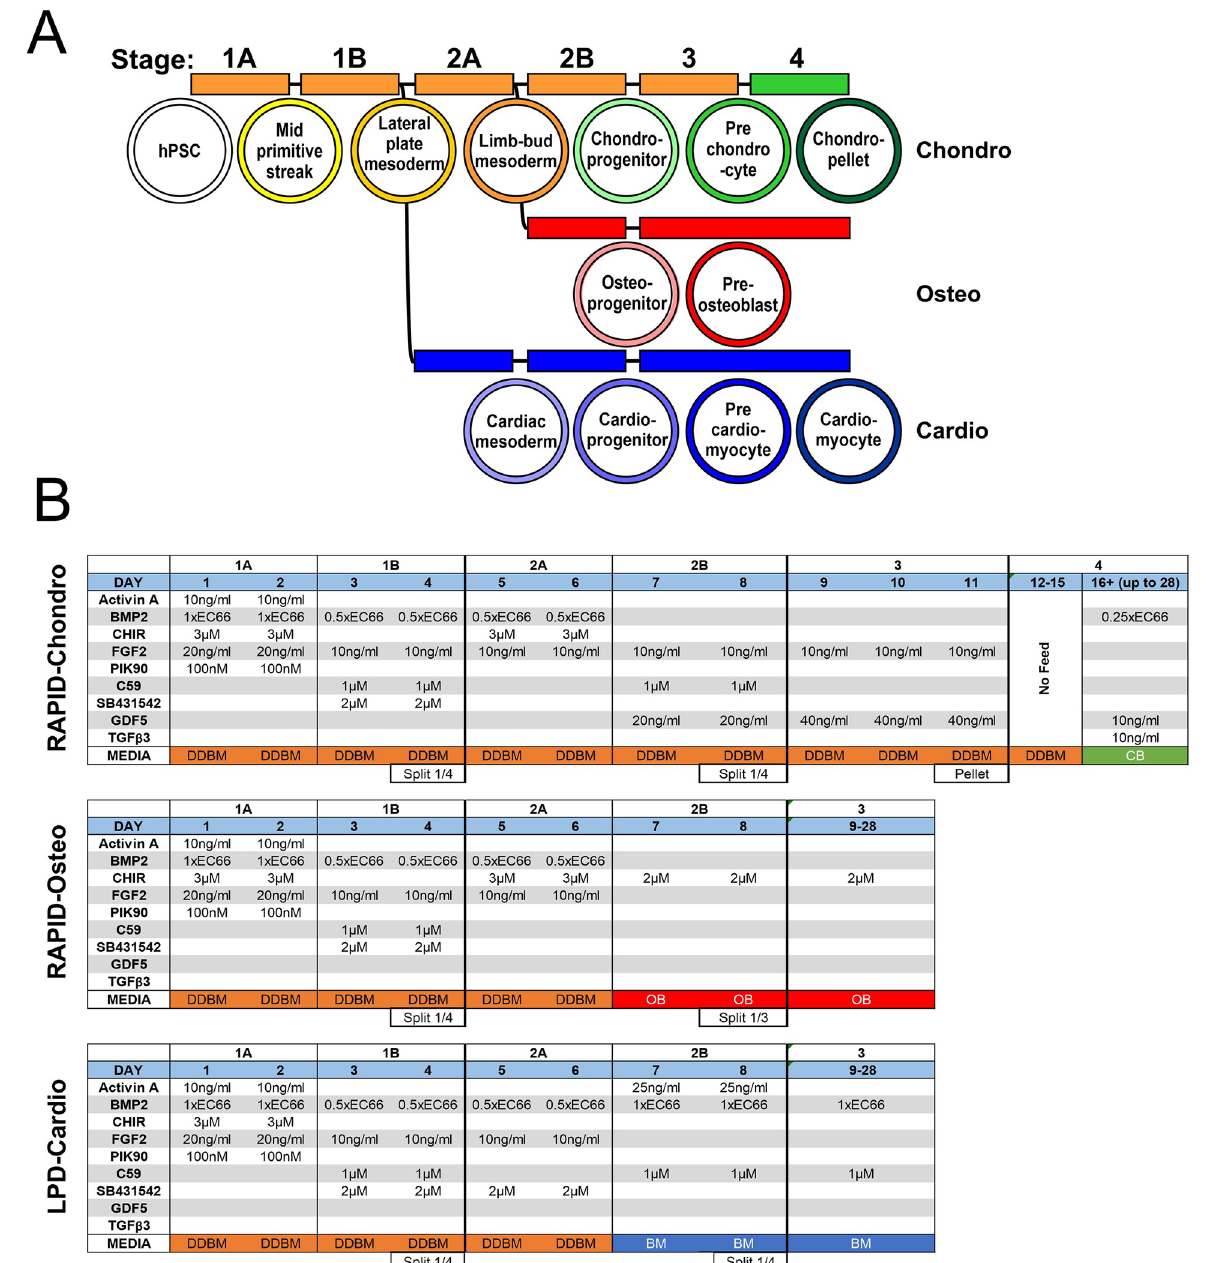
Fig 1. RAPID protocol. A) Flow diagram of stages and media required to achieve all 3 cell types during the RAPID protocol (including LPD). B) Growth factor regimen for RAPID (including LPD) protocols at each day for the chondrogenic, osteogenic and cardiogenic